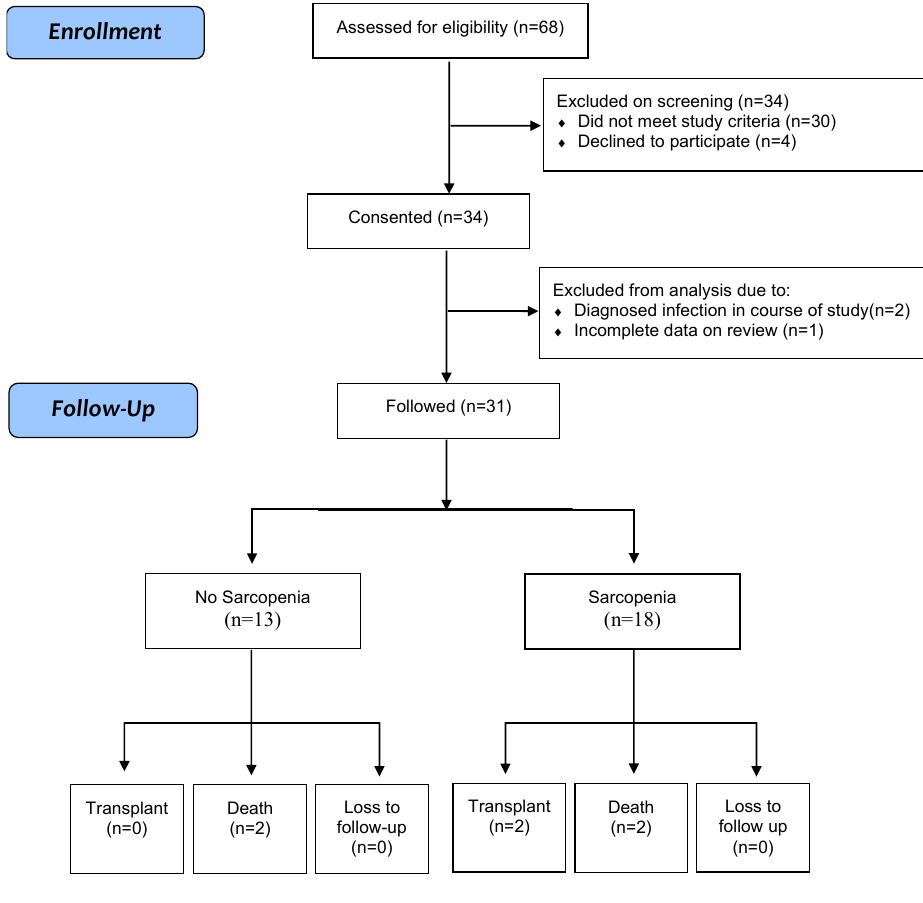
Figure 1. Flow Figure 1. Flow Diagram.